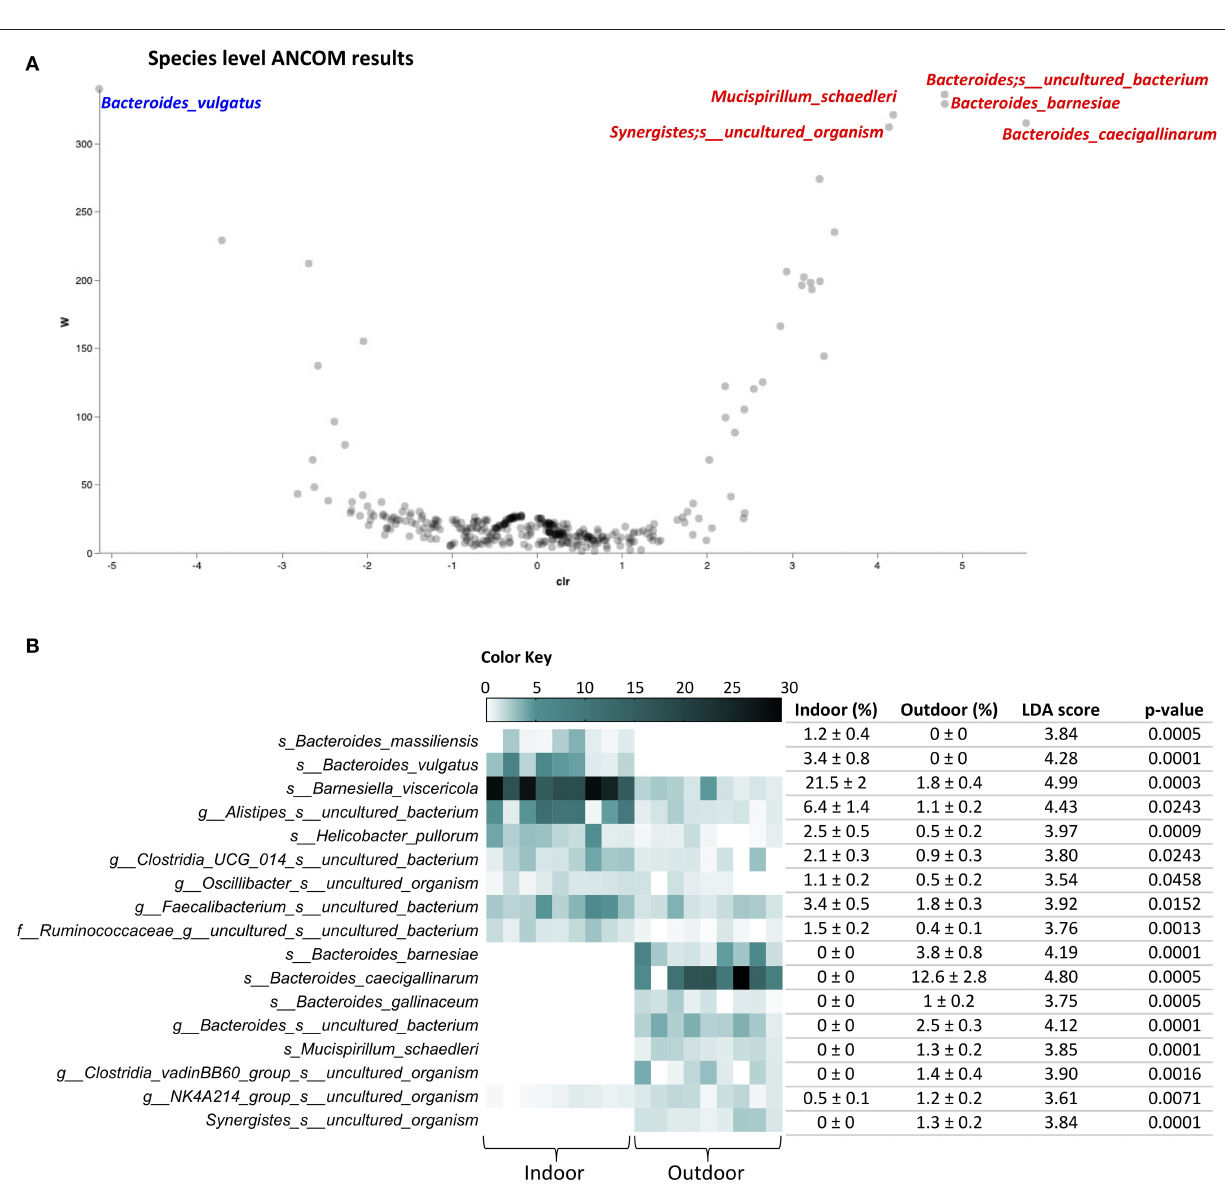
FIGURE 3 | Species-level cecal microbiota assortment. (A) The ANCOM differential abundance volcano plot at the species level. Only significant bacterial species showing high w-stats are labeled and colored in blue or red for Indoor and Outdoor groups, respectively. (B) Bacterial species discriminating the cecal microbiota of Indoor and Outdoor chickens based on linear discriminant analysis (LDA) combined with effect size (LEfSe) algorithm ( p > 0.05 for both Kruskal–Wallis and pairwise Wilcoxon tests and a cutoff value of LDA score above 2.0; only species with relative abundances > 1% in at least one group are listed). Heatmap, mean ± SEM, LDA scores, and p -values are represented for each indoor-enriched and outdoor-enriched bacterial species, as identified by